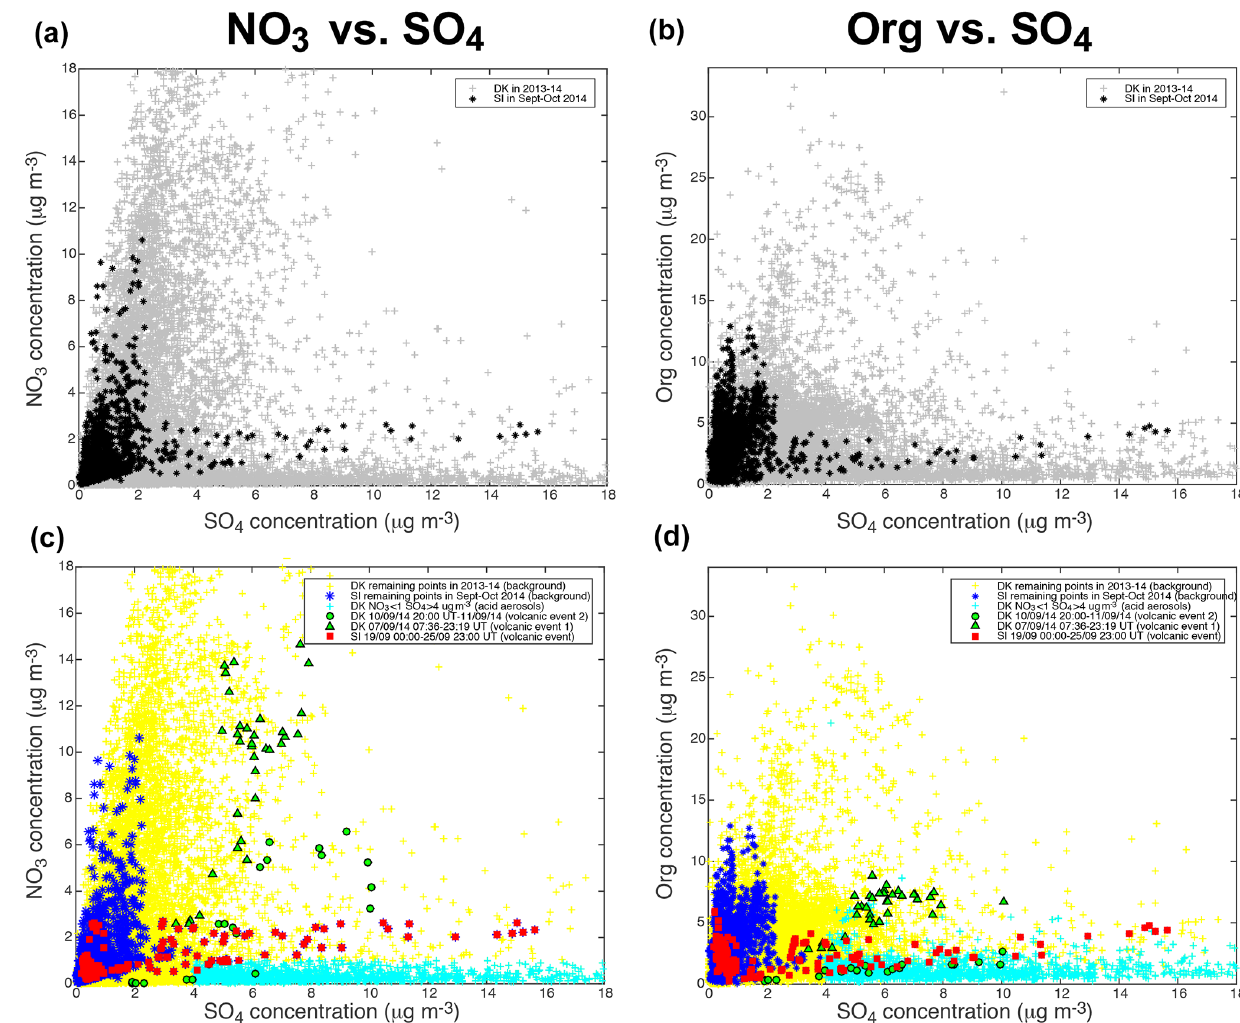
Figure 6. Same as Fig. 5 but for (a, c) ACSM NO 3 and (b, d) ACSM Org vs. ACSM SO 4 mass concentrations.